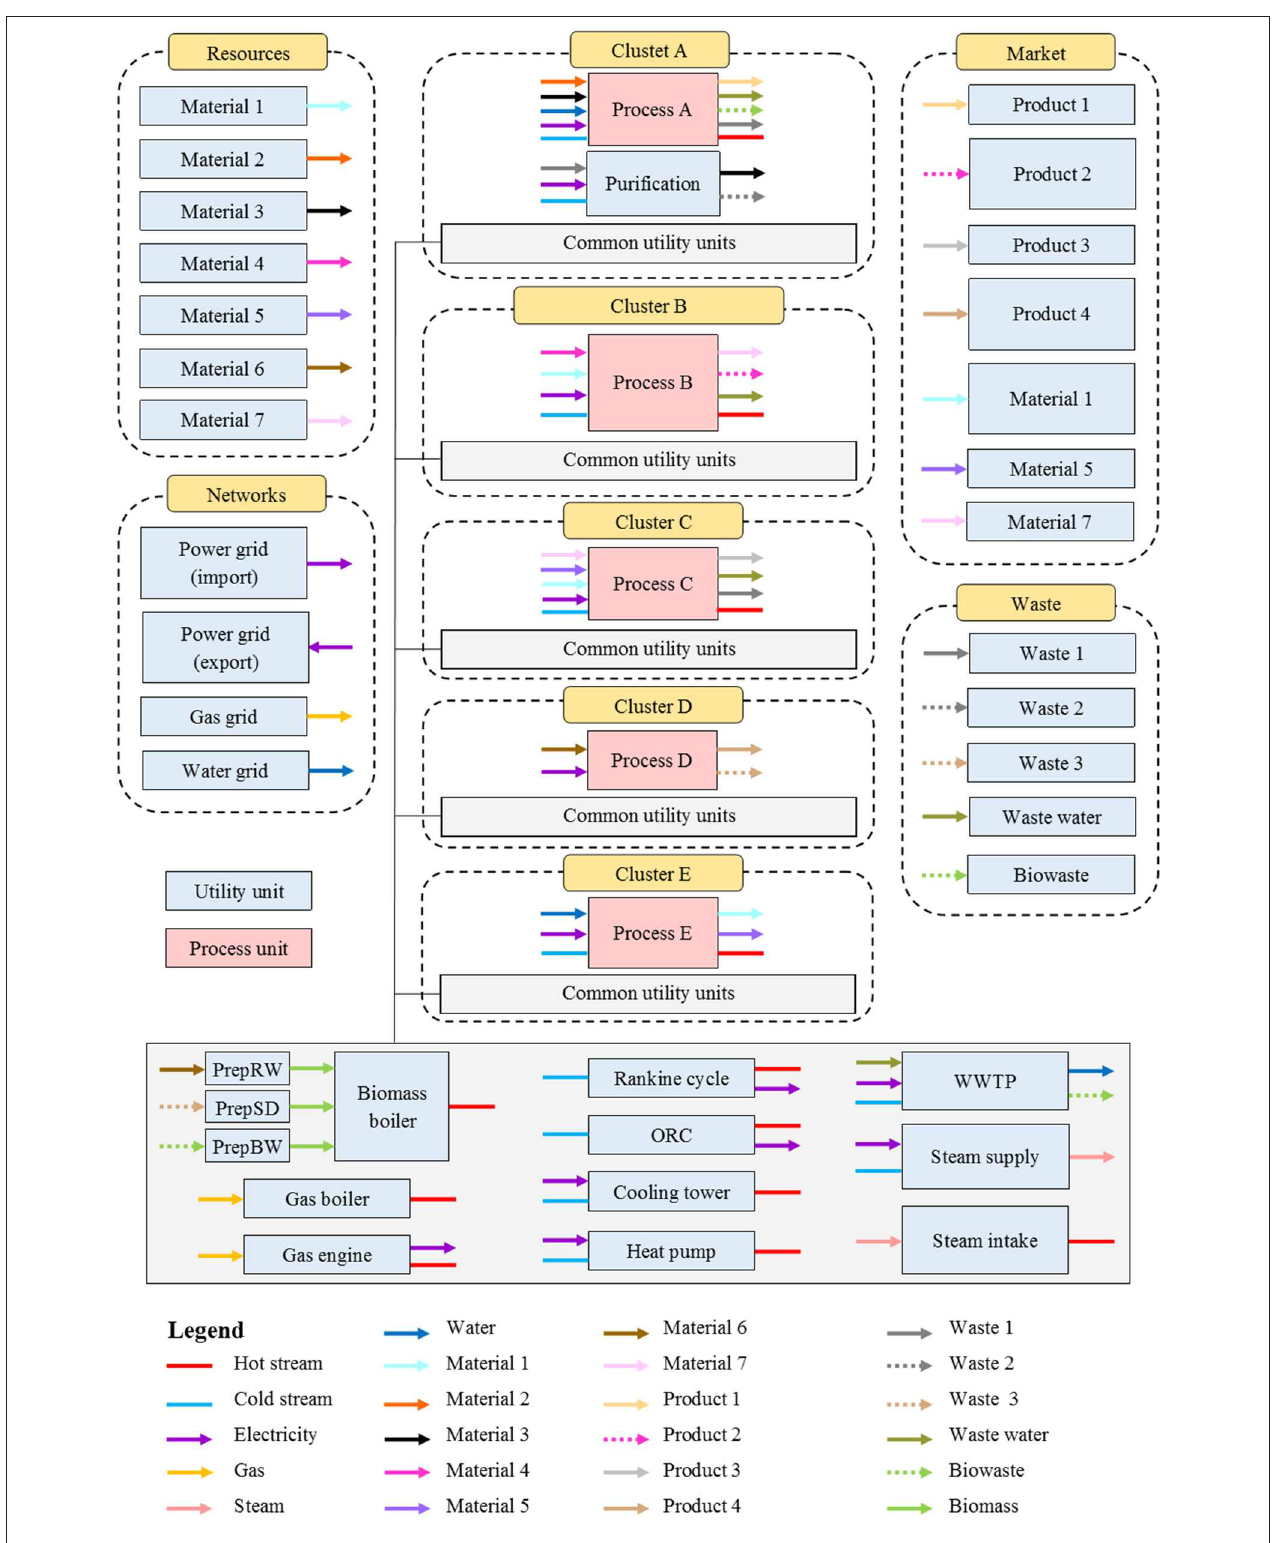
FIGURE 6 | Superstructure representation used for the case study.